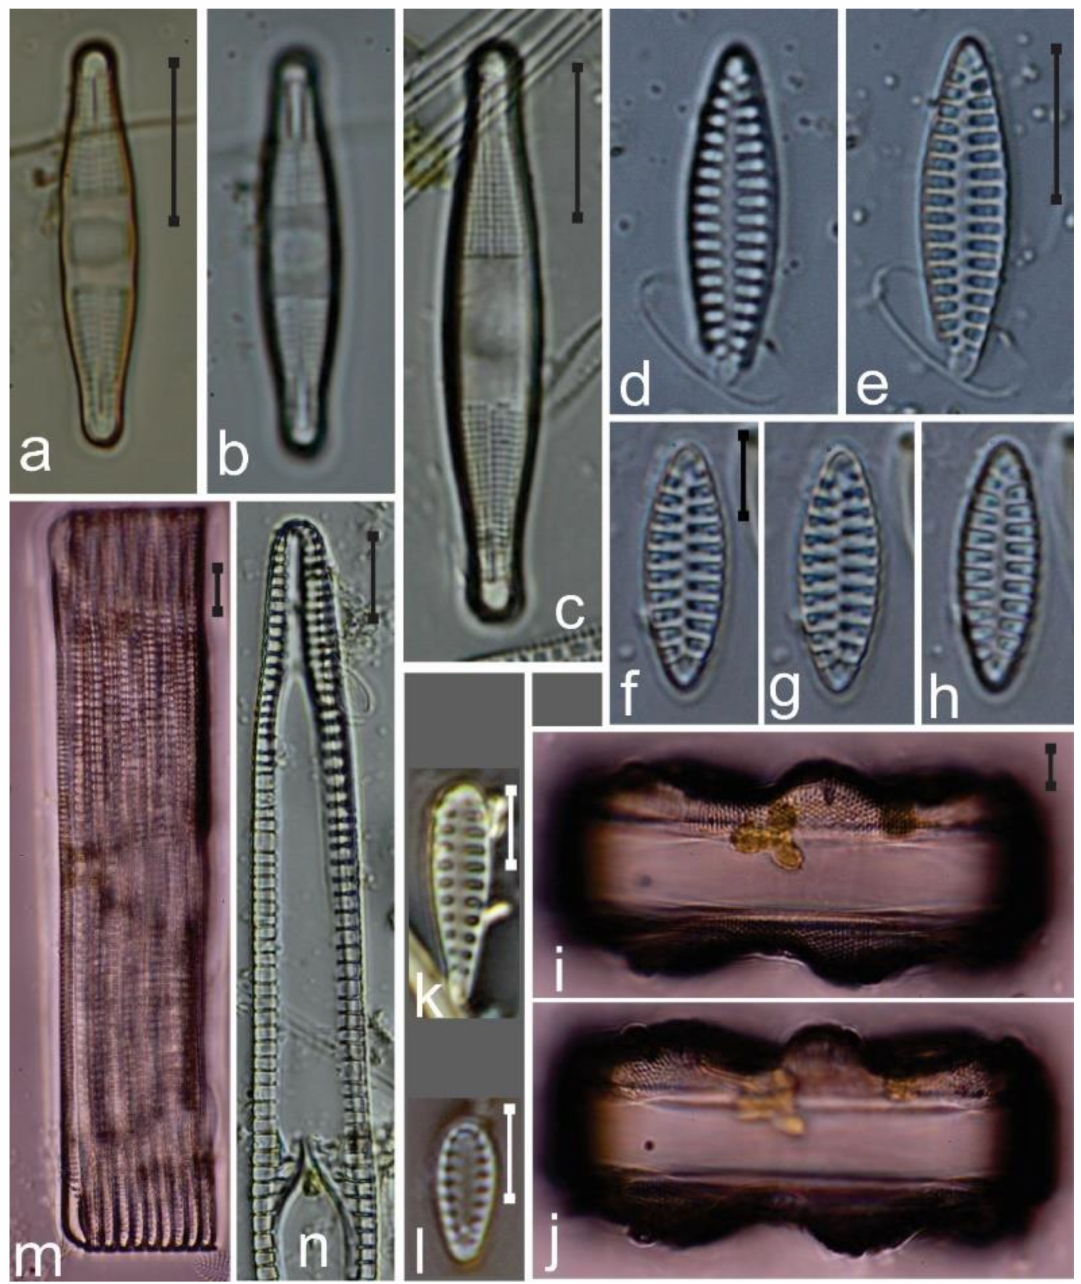
Figure 16. ( a – c ) Talaroneis sp.; ( d – h ) Opephora pacifica ; ( i , j ) Aulacodiscus sp. frustule in girdle view showingthecingulum; ( k ) Gedaniellamutabilis ; ( l ) Staurosirellaguenter - grassii ; ( m , n ) Rhabdonemaadriaticum , image m girdle view showing the bands. Scale bar: a – j , m , n = 10 µ m; k , l = 5 µ